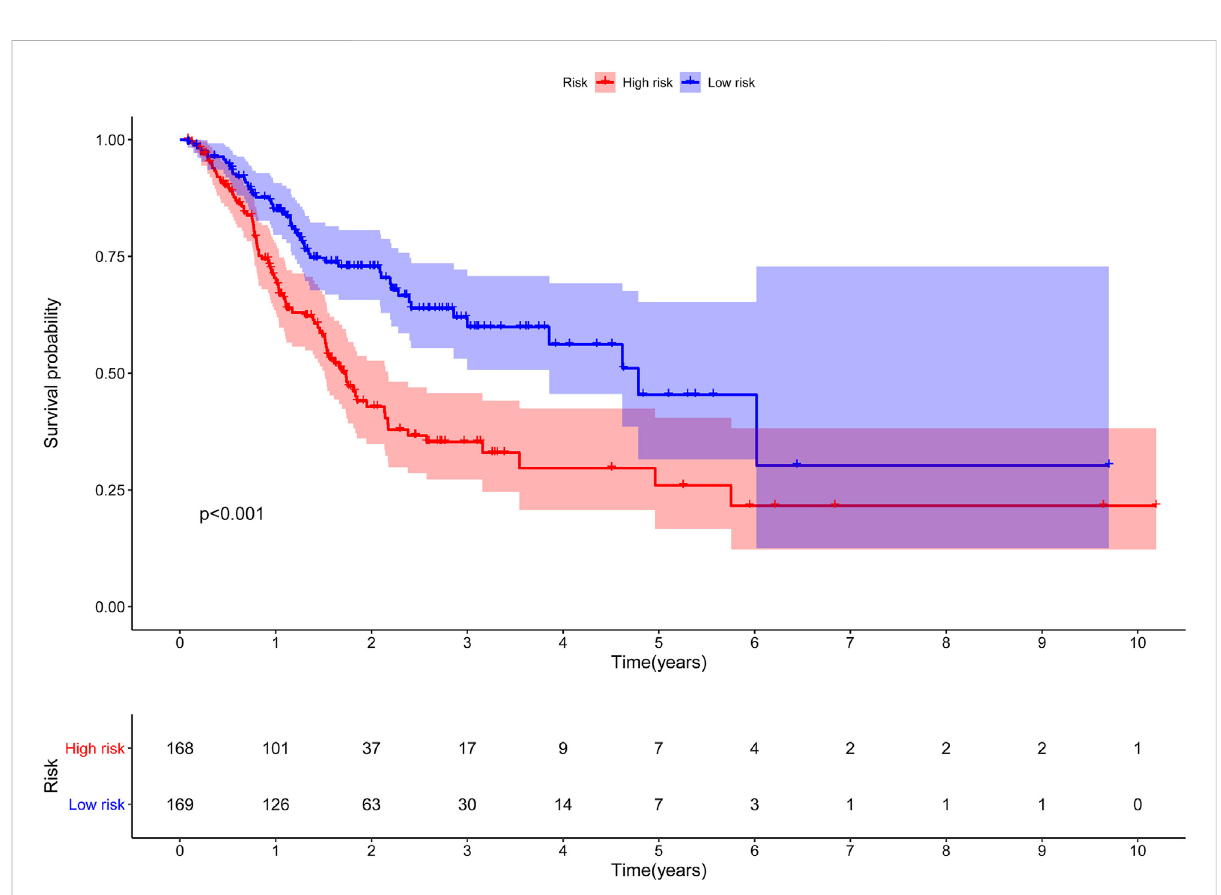
FIGURE 4 The Kaplan-Meier survival curve of risk score based on seven glycolysis-related lncRNAs.